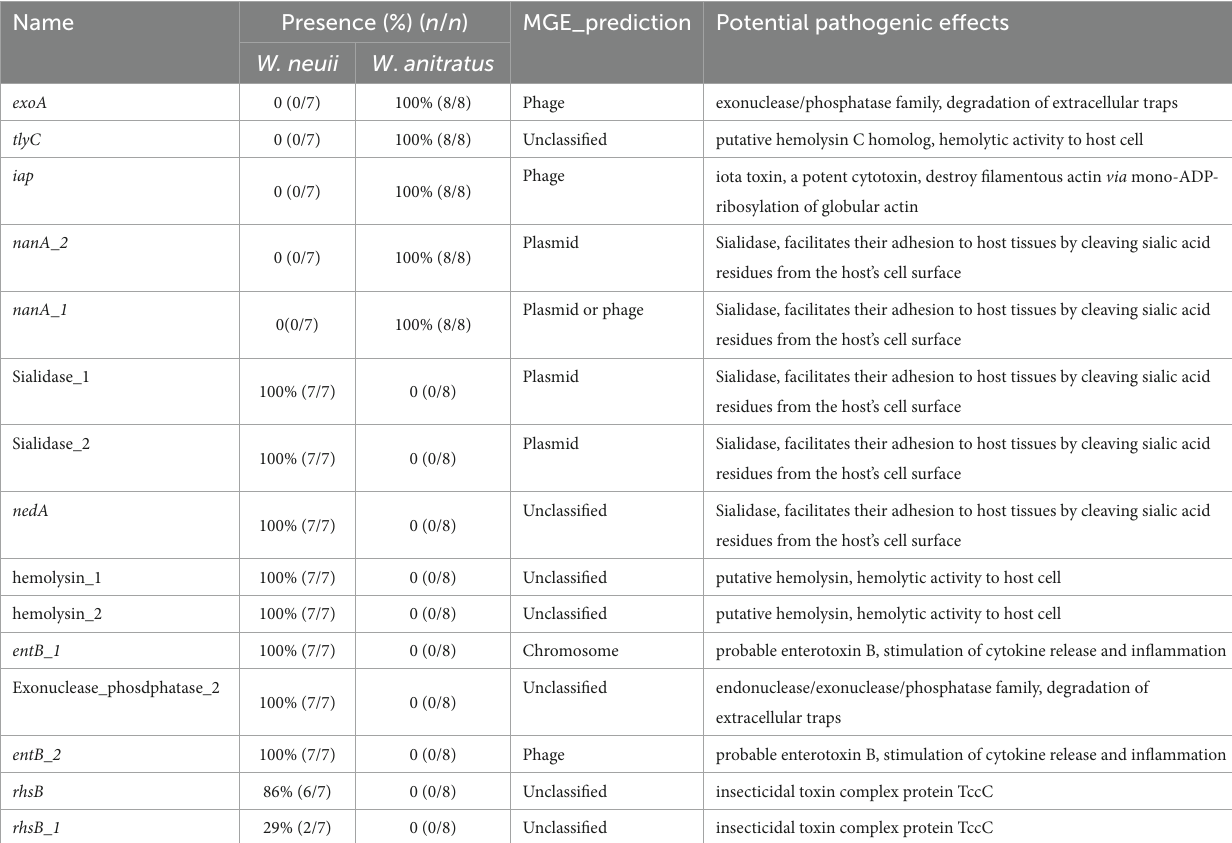
TABLE 2 Characterization of the virulence factor coding genes in Winkia